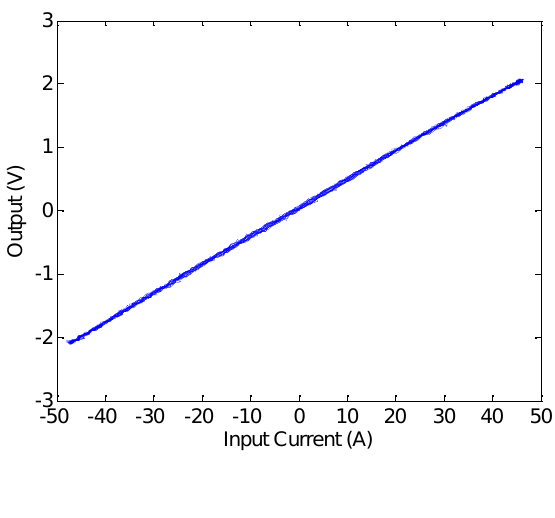
Figure 13. Linearity of the improved design.